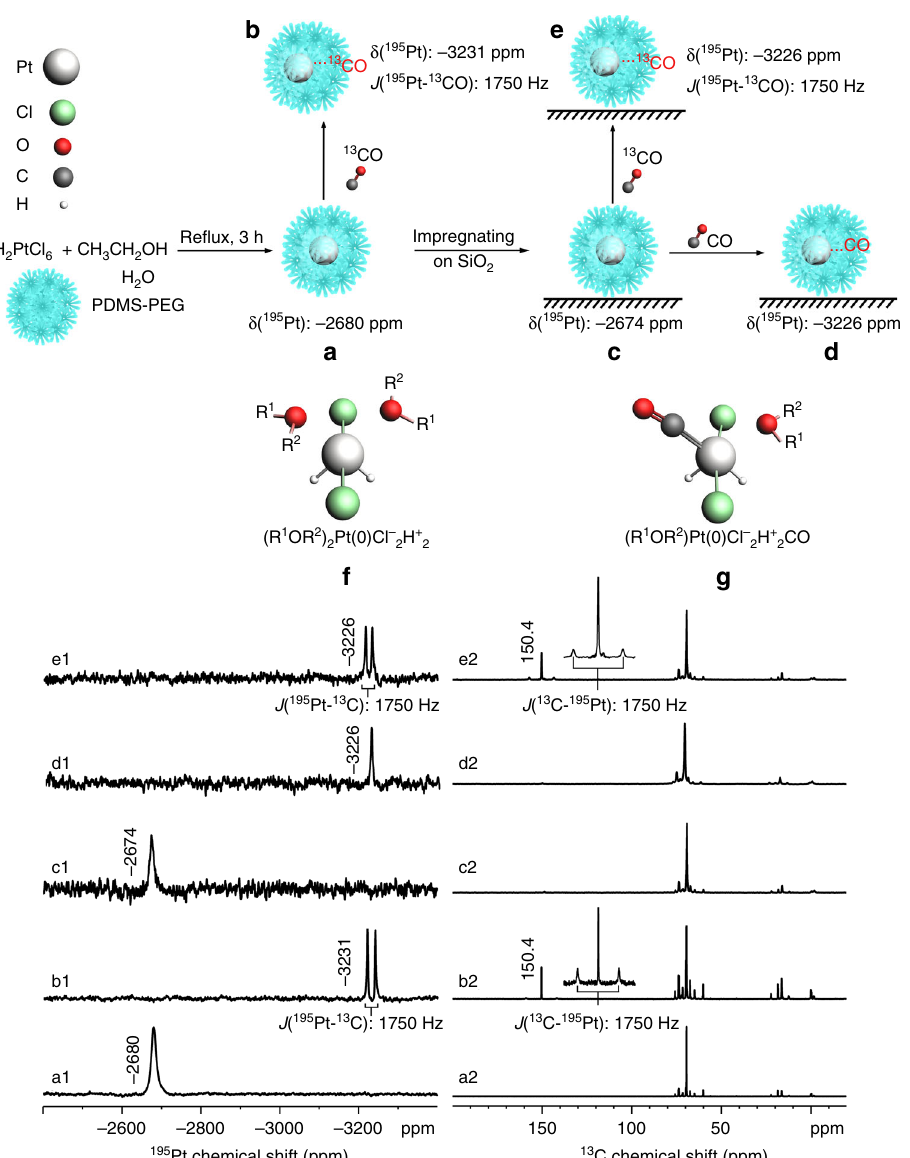
Fig. 2 195 Pt NMR (a1 – e1) and corresponding 13 C NMR (a2 – e2) spectra of a Pt 1 @PDMS-PEG liquid; b 13 CO treated Pt 1 @PDMS-PEG liquid; c 2 wt% Pt 1 @PDMS-PEG/SiO 2 ; d CO treated 2 wt% Pt 1 @PDMS-PEG/SiO 2 ; e 13 CO treated 2 wt% Pt 1 @PDMS-PEG/SiO 2 . Note: 2 wt% refers to the Pt loading on SiO 2 ; f , g are the selected density functional theory (DFT) models of pseudo octahedral structure of (R 1 OR 2 ) 2 Pt(0)Cl − 2 H + 2 (R 1 , R 2 are H, C, or Si groups) and (R 1 OR 2 )Pt(0)Cl − 2 H + 2 CO in polydimethylsiloxane-polyethylene glycol (PDMS-PEG), respectively. Note: the sketch only serves as an illustration